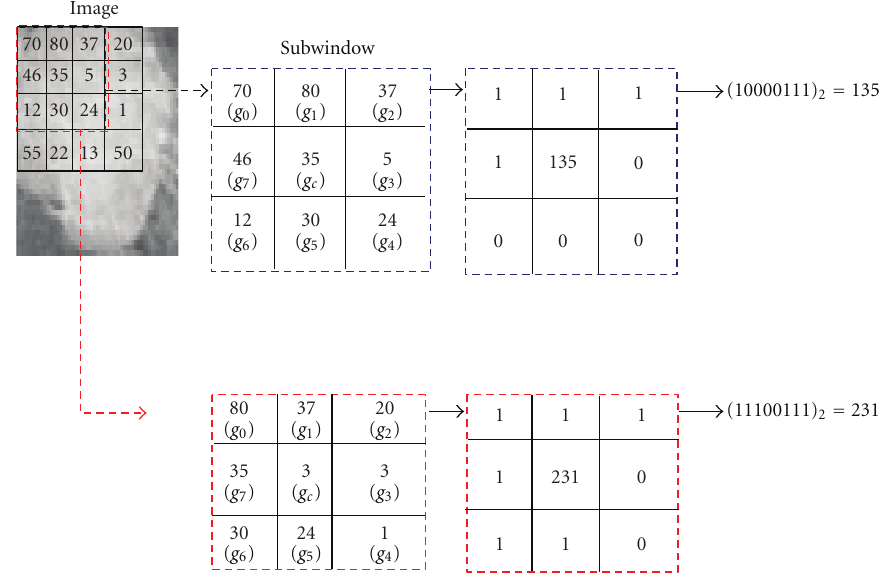
Figure 1: Example of basic LBP